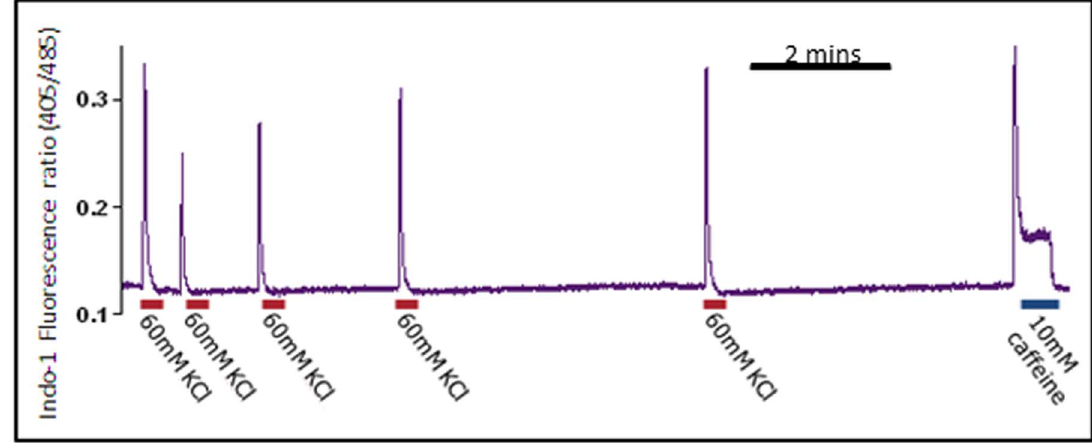
Figure 2. Depolarisation with KCl. Representative experiment where skin-derived equine myotubes were subjected repeatedly to depolarization with 60 mM KCl (red line). 10 mM caffeine responses (blue line) are shown for comparison. Note that responses are reproducible and near maximal within approximately 4 minutes.